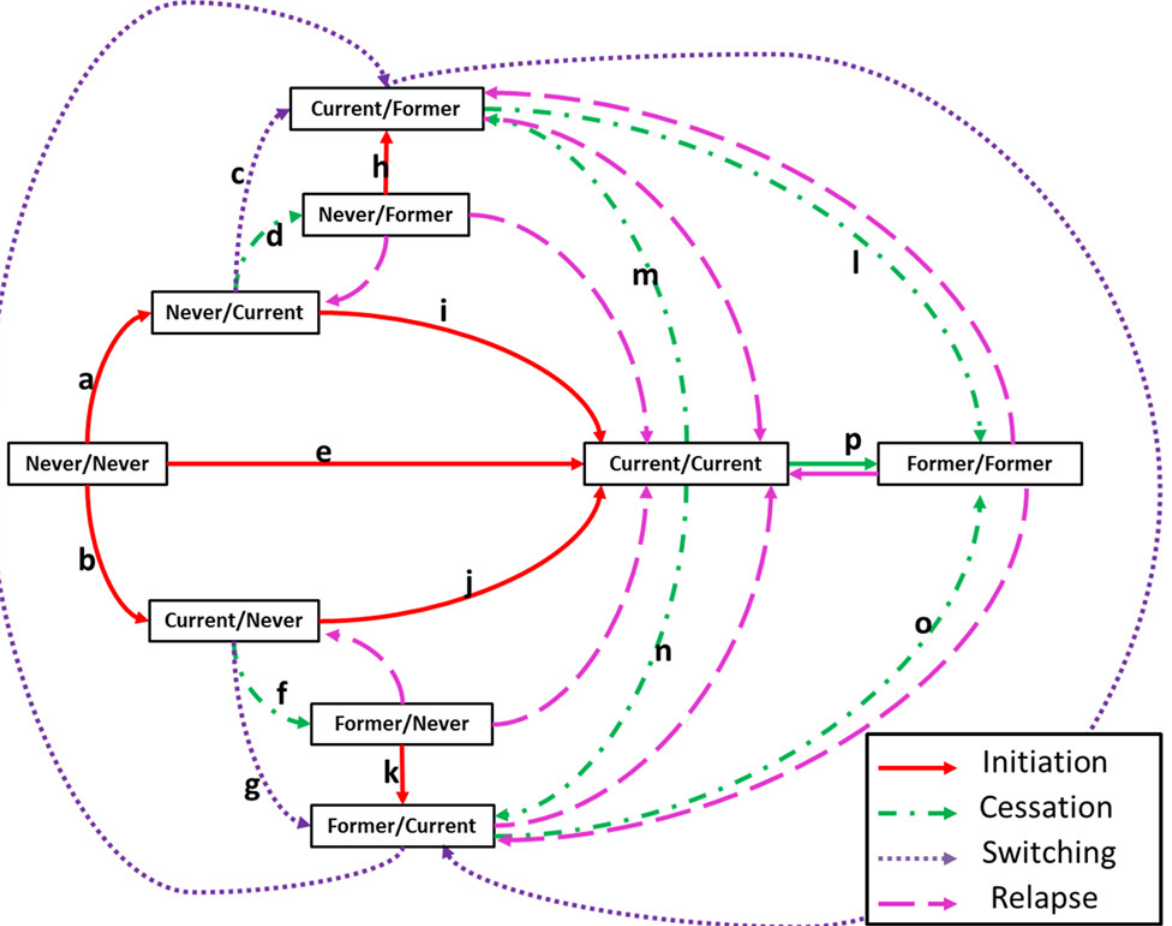
Fig 1. Tobacco use status transitions for a two product model formulation. Transition behaviors (illustrated by directed edges) are categorized into four groups: initiation, cessation, switching, and relapse. Nine possible use states are represented as boxes in which the first and second terms correspond to use of the first and second product,